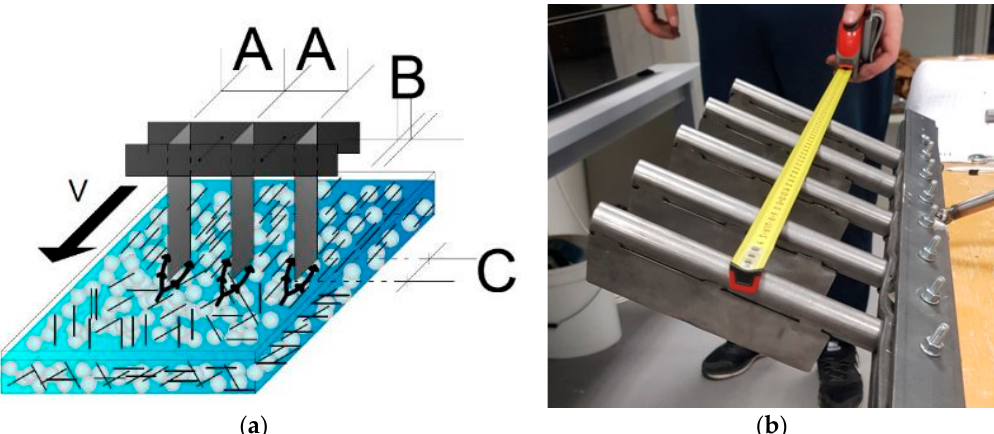
Figure 8. ( a ) Demonstration of controlled fibre orientation research; ( b ) a levelling tool; where: A—Spikes spacing (mm), B,C—Spike type, v—direction of movement.